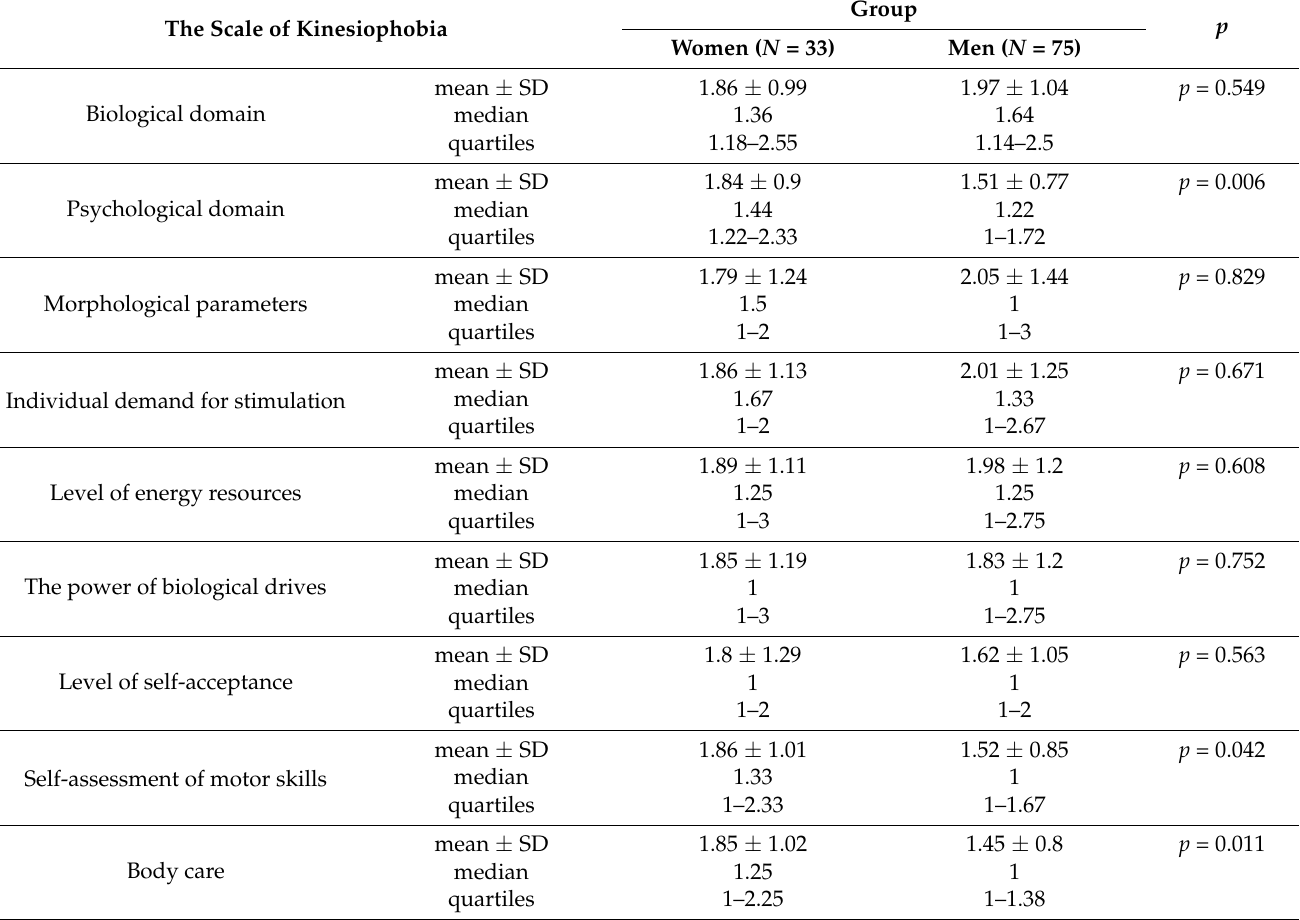
Table 3. Comparison of domains and subdomains of kinesiophobia among men and